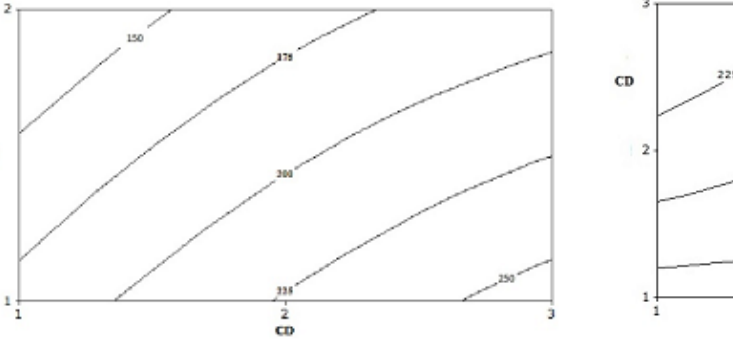
Fig. 4. Contour diagram of average water droplet size in terms of demulsifier types and concentration of